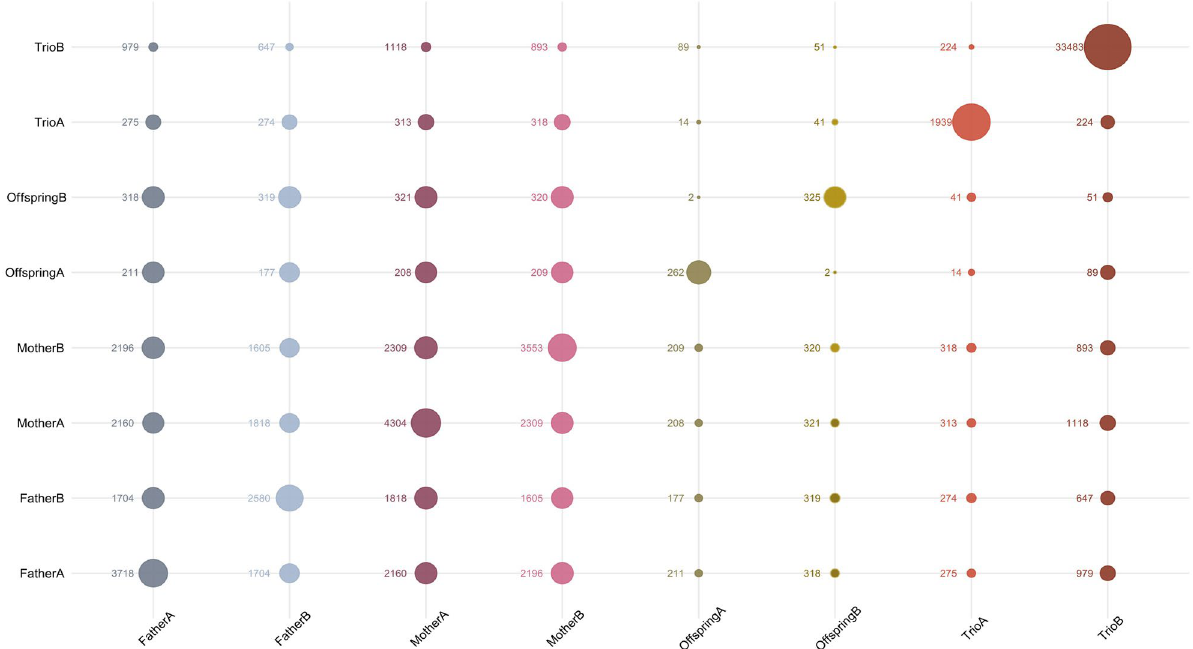
Figure 3. Geom-count plot illustrating the number of SNPs gathering Mendelian errors assigned to two-by-two of the eight ME classes defined according to the assignment of the origin of the error to a member of the parent– offspring trio and the frequency of the alleles at a